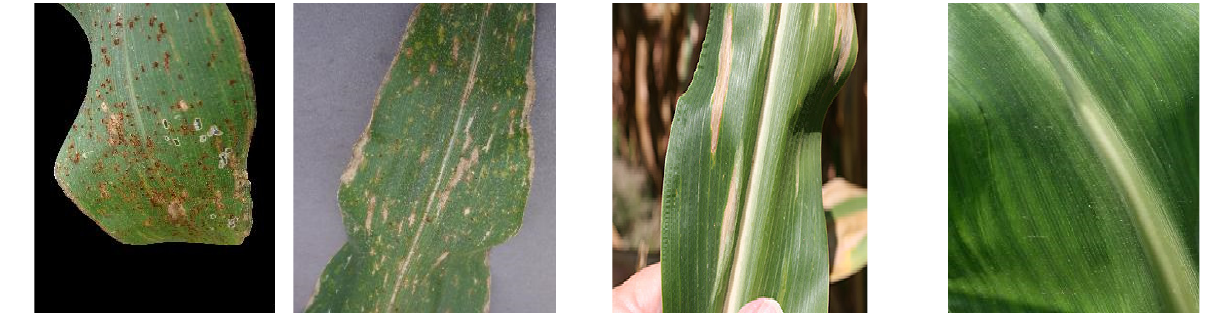
Figure 3. Images from the dataset. (Common Rust, Gray Leaf Spot, Blight, Healthy).